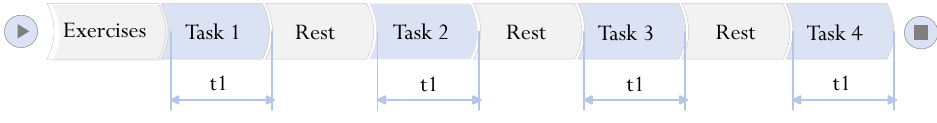
Figure 1. Flow chart of each group of experiments.